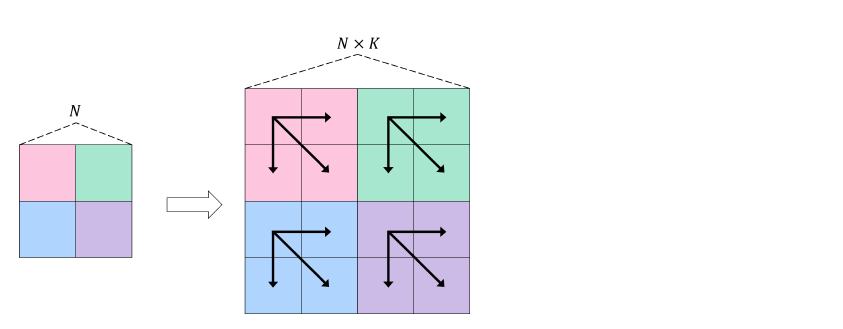
Figure 10. Increased pixel appearance when the image was enlarged horizontally and vertically ( K = 2). Different colors indicate different pixel values.